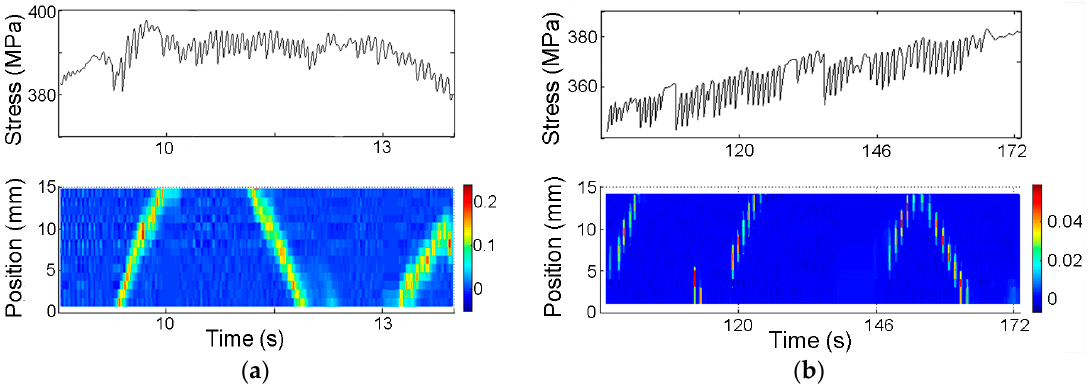
Figure 6. Similar maps for samples of the alloy subjected to 12 ECAP passes: ( a ) r a = 1.4 × 10 − 2 s − 1 ; ( b ) r a = 10 − 3 s − 1 .